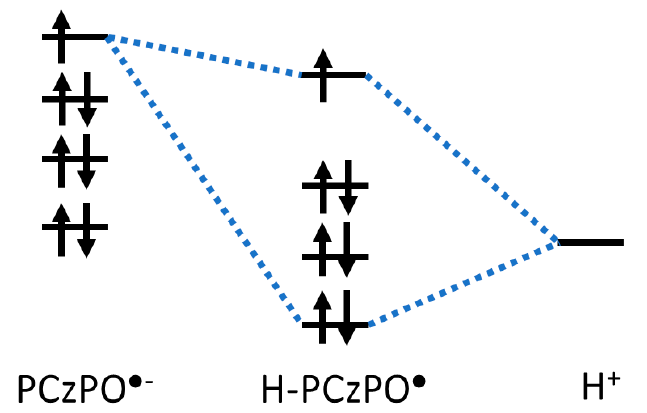
Figure 4. 3D electron density distribution of the frontier orbitals of PCzPO •- and H-PCzPO • calculated under DFT-B3LYP/6-311G(d,p) level of theory.